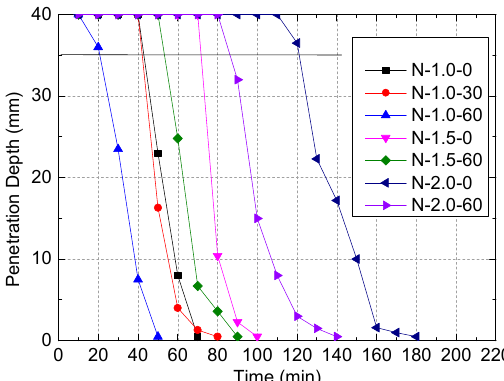
Figure 2. The initial and final setting times of SBM specimens.